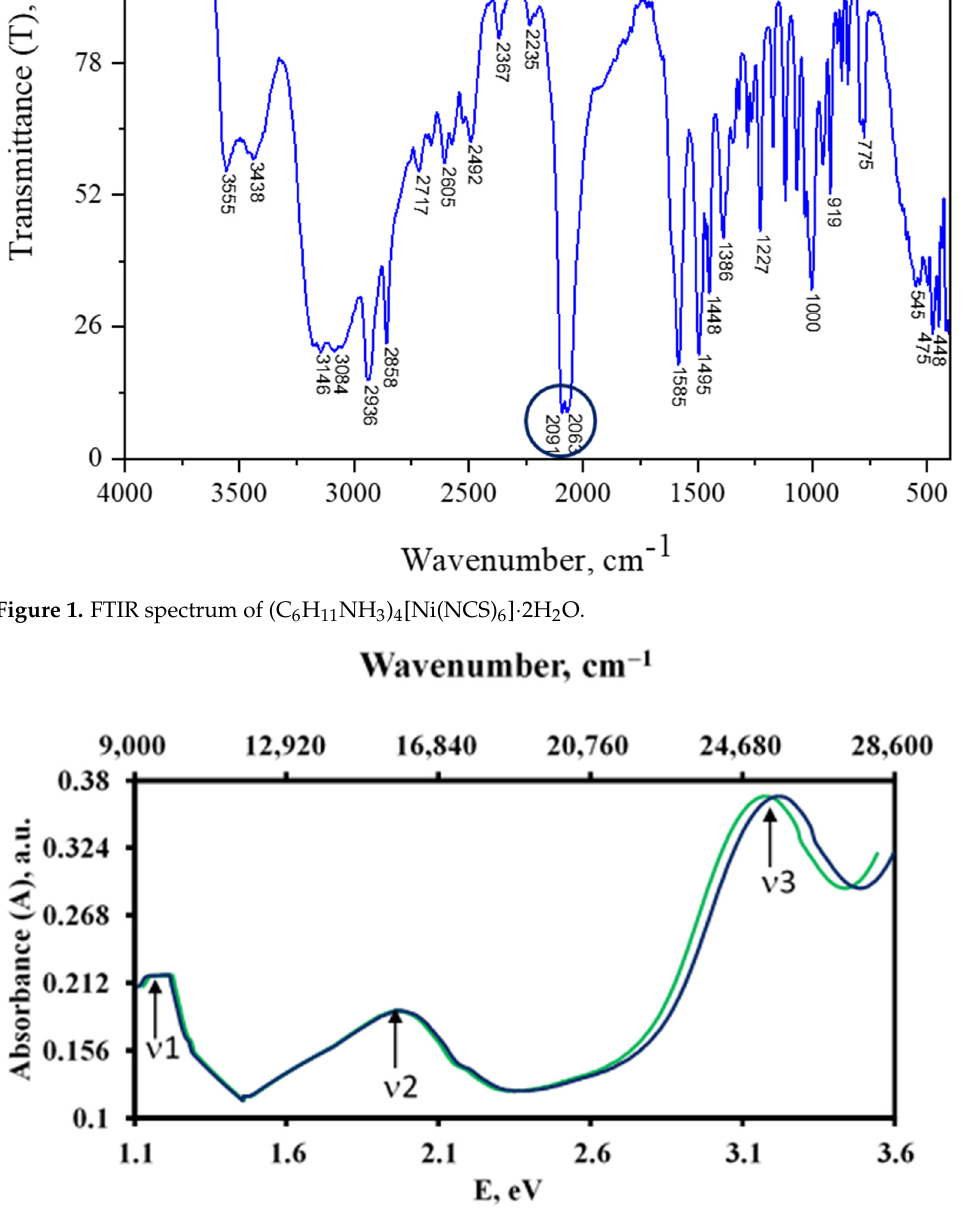
Figure 2. UV-Vis-NIR absorbance spectrum of (C 6 H 11 NH 3 ) 4 [Ni(NCS) 6 ] · 2H 2 O.